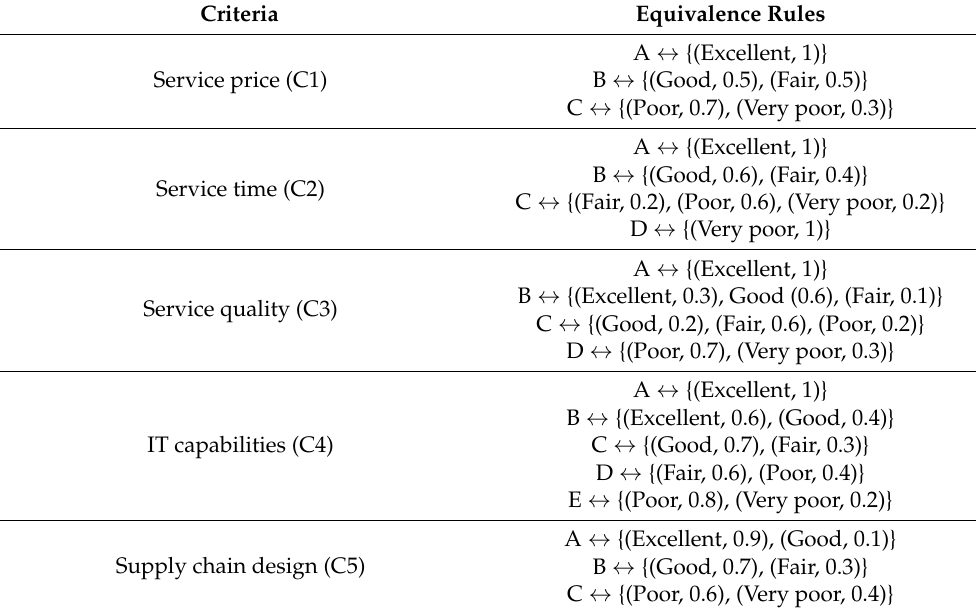
Table 9. Equivalence rules for each